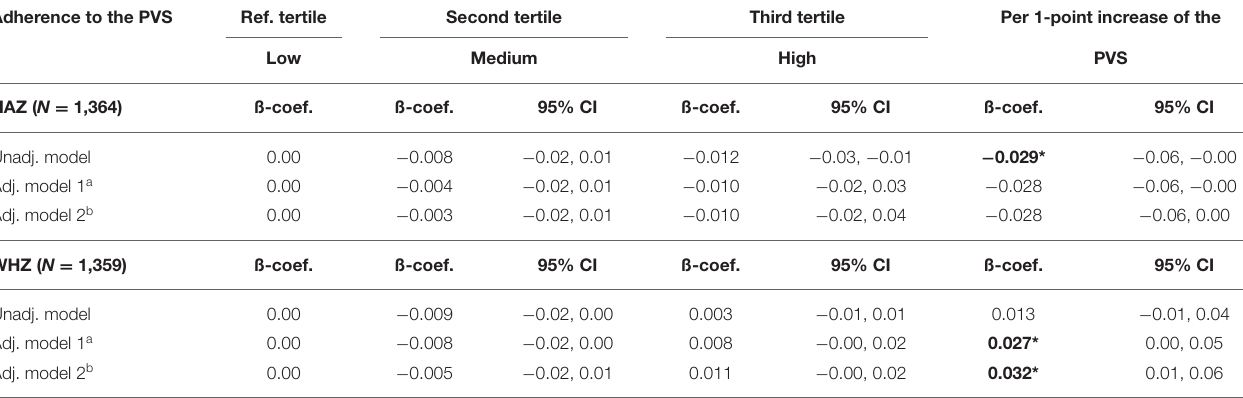
FIGURE 3 | Visualization of the RRR rotated factor loadings of the rainfall indicators that best describe the RRR-derived PVS. Rainfall indicators with factor loadings of ≥ |0.20| indicate relevant contributions to the PVS. A positive deviation indicates a higher manifestation (increase) of the respective rainfall indicators, while a negative deviation indicates a lower manifestation (reduction).